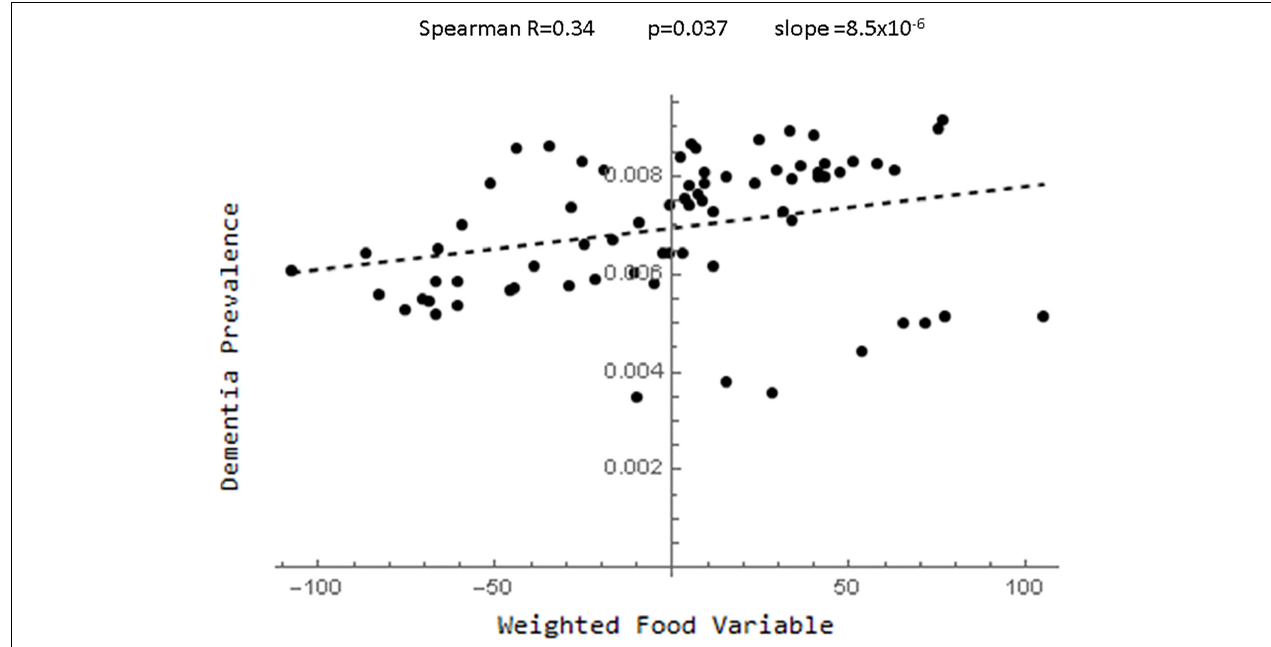
FIGURE 4 | Plot of the relationship between the food index derived by standardizing the food variables and multiplying each by their partial correlation coefficients and